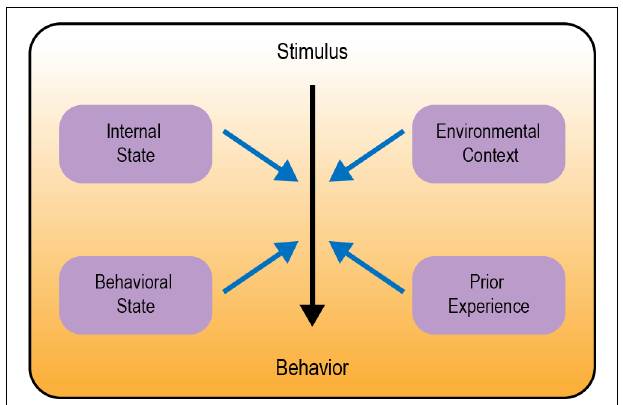
FIGURE 1 | Overview of different types of behavioral modulation. Neural circuits in the brain transform a sensory stimulus into a behavioral response (represented by the color gradient). Black arrow depicts the core circuit underlying behavior; blue arrows depict modulation of this